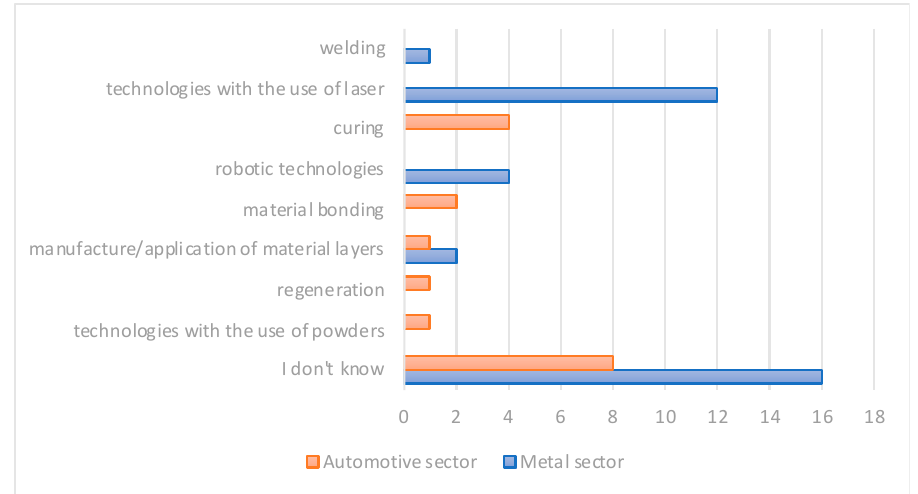
Figure 3. Interest in implementing AM. Answers declared by respondents from the automotive and metal industries.